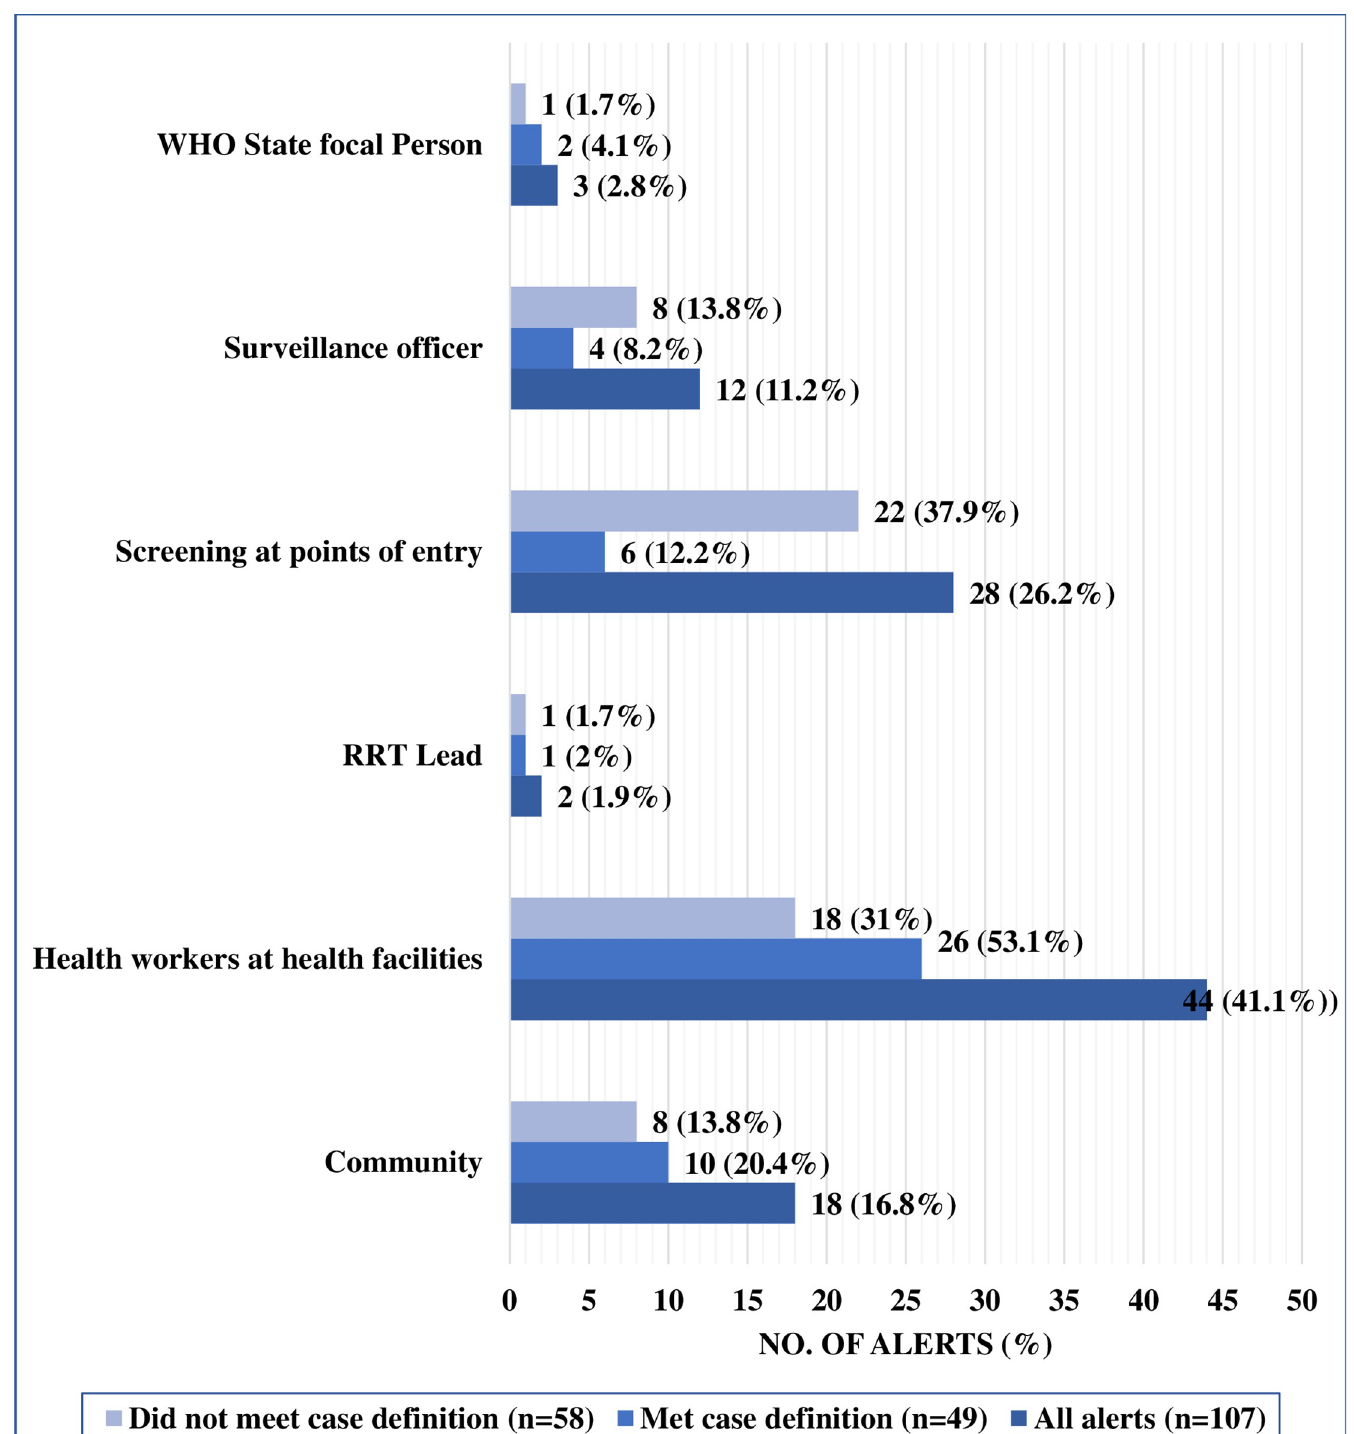
Fig 3. Sources of identification of EVD alerts in South Sudan—August 2018 to November